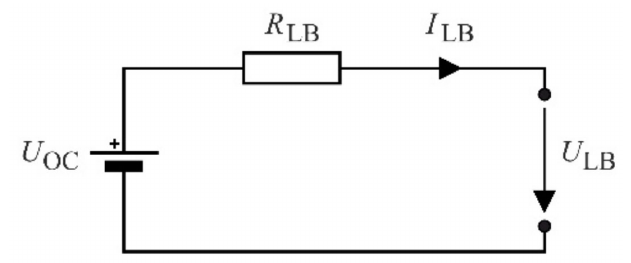
Figure 3. Equivalent electrical circuit for the lithium-ion battery-based energy storage